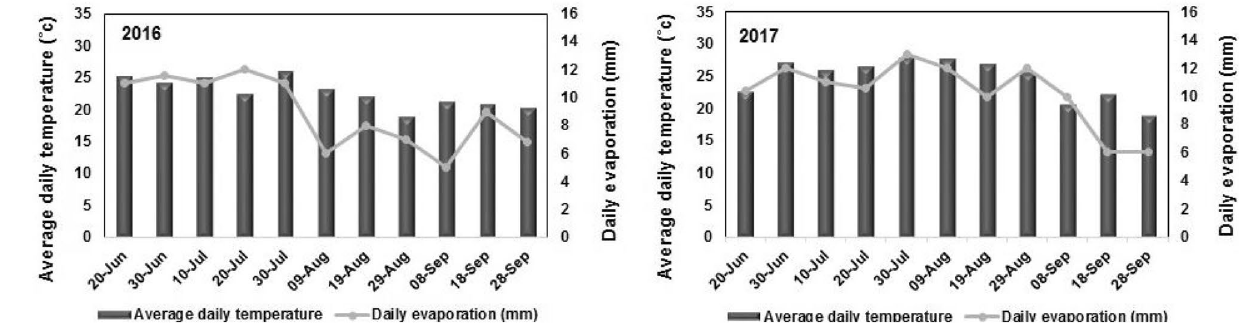
Figure 1. Average of meteorological data during the two growing season of sweet